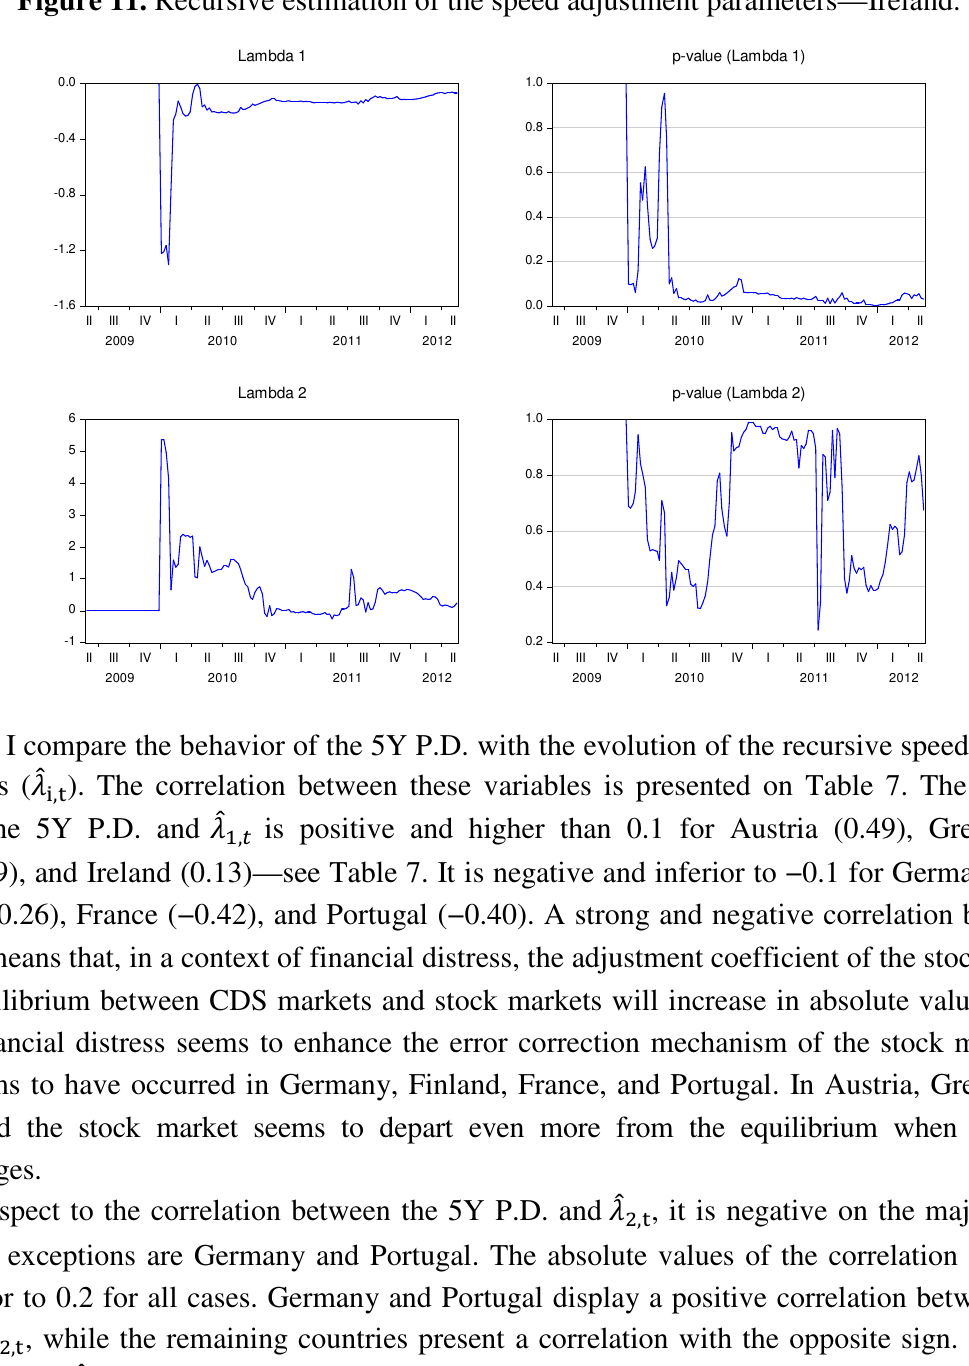
Figure 11. Recursive estimation of the speed adjustment